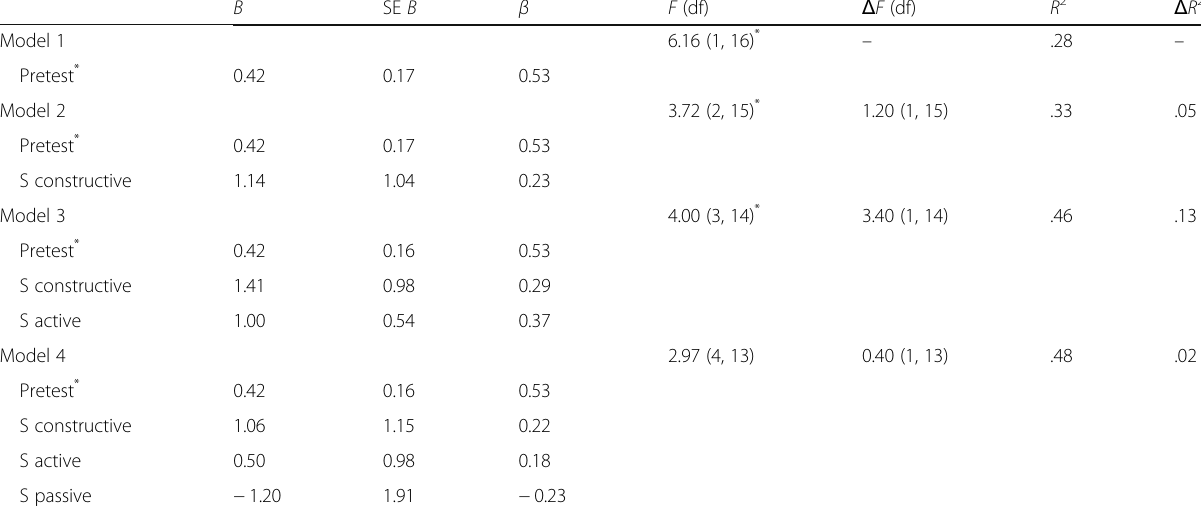
Table 7 Regression models predicting transfer scores from proportions of student talk types B SE B